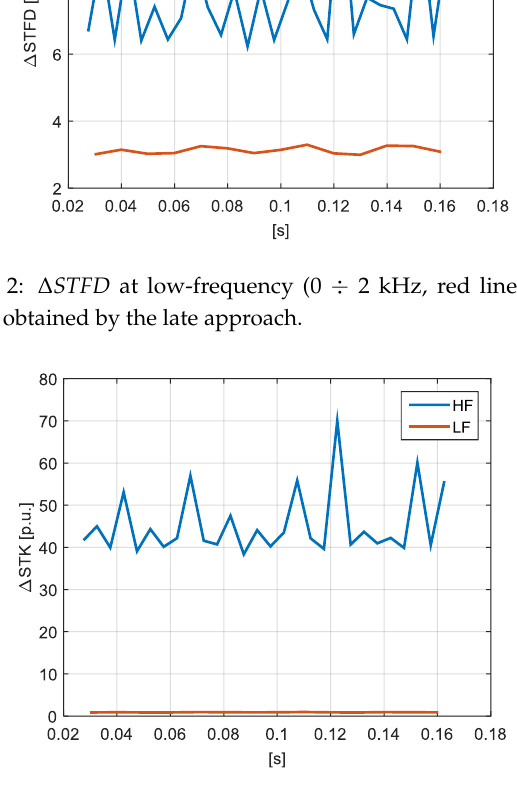
Figure 17. Case study 2: Δ STK at low-frequency (0 ÷ 2 kHz, red line) and at high-frequency (2 ÷ 150 kHz, blue line) obtained by the late approach.